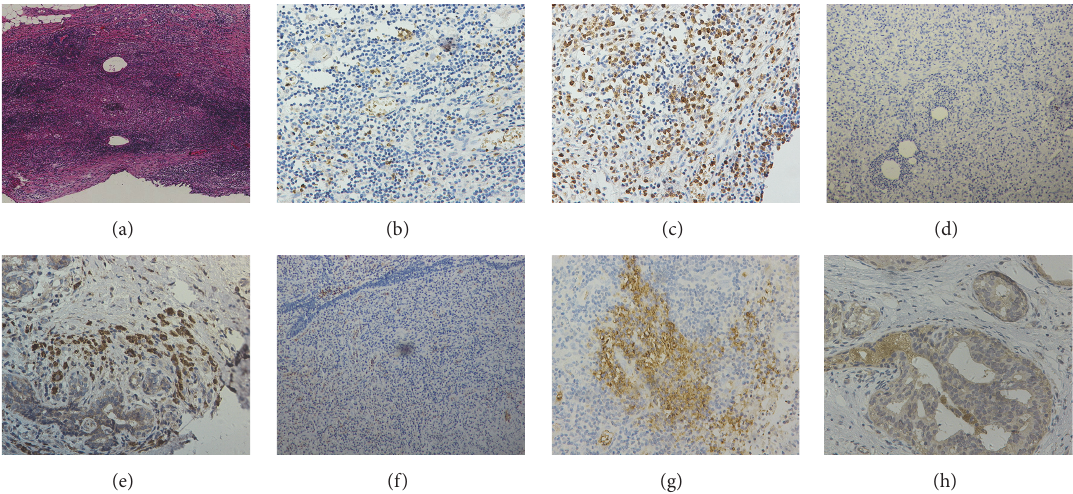
Figure 2: Representative illustrations of the expression of cytokines in PDM and normal breast tissues. (a) Low-power magnification of PDM (hematoxylin and eosin, × 40). (b) Low expression of IFN- 𝛾 (IHC, × 200). (c) High expression of IFN- 𝛾 (IHC, × 200). (d) Low expression of IL-12A (IHC, × 100). (e) High expression of IFN- 𝛾 (IHC, × 200). (f) Low expression of IL-17A (IHC, × 100). (g) High expression of IL-17A (IHC, × 200). (h) The expression of inflammatory cytokines in normal breast ductal epithelium and stromal cells (IHC, × 200).